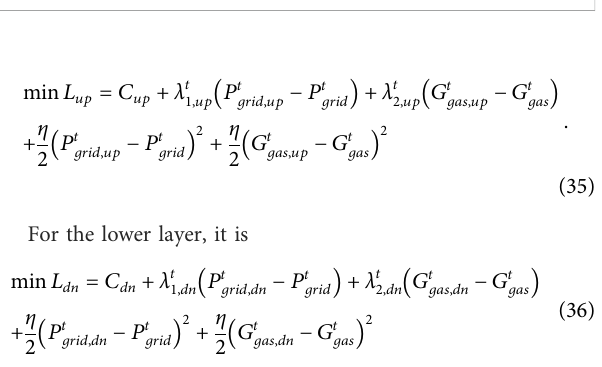
FIGURE 8 Electric-power